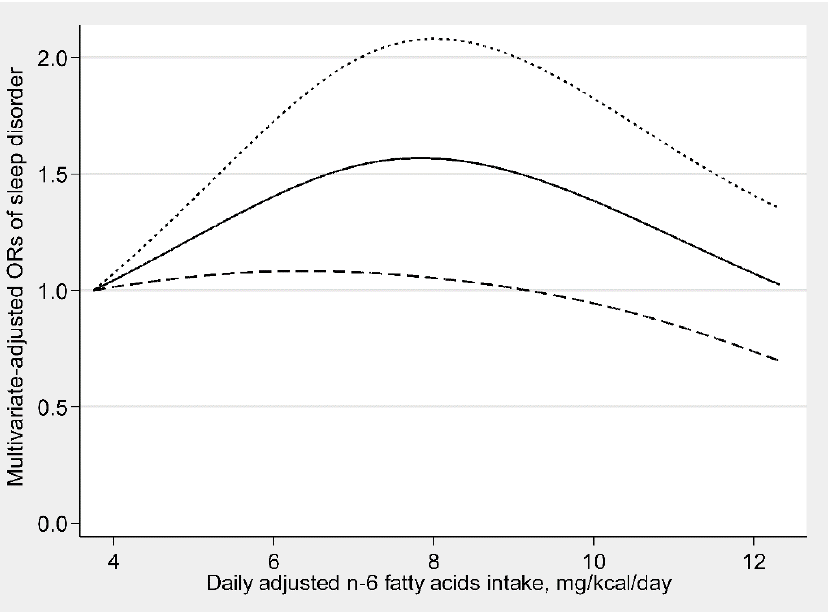
Figure 1. Restricted cubic spline model of the odds ratios (ORs) of sleep disorders with dietary ω-6 fatty acids consumption. The solid line and dashed lines represent the estimated ORs and the 95% confidence intervals.